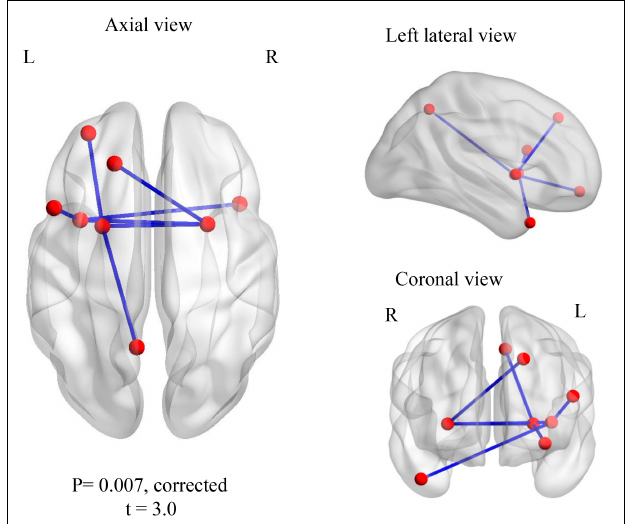
FIGURE 2 | Within TD group contrast: familiar > unfamiliar music. Increased gamma 1 band (30–55 Hz) wPLI phase synchronization during processing of familiar music in TD